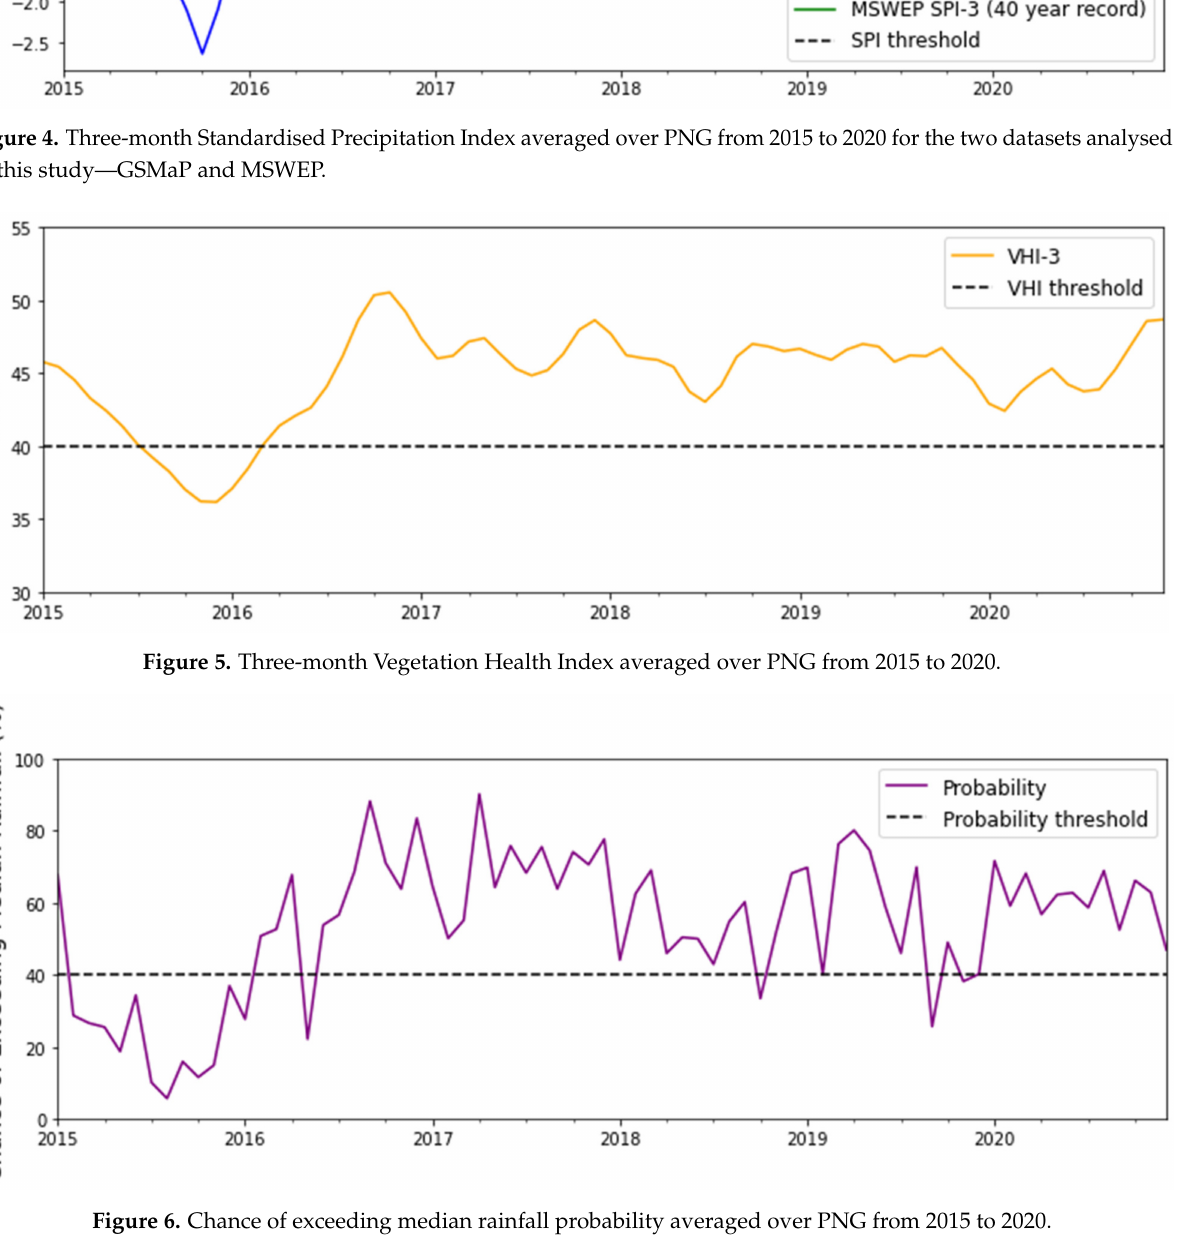
Figure 6. Chance of exceeding median rainfall probability averaged over PNG from 2015 to